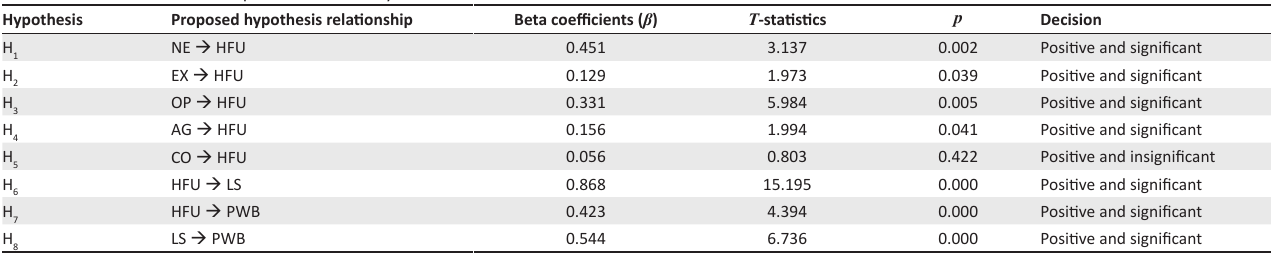
TABLE 5: Results of structural equation model analysis.